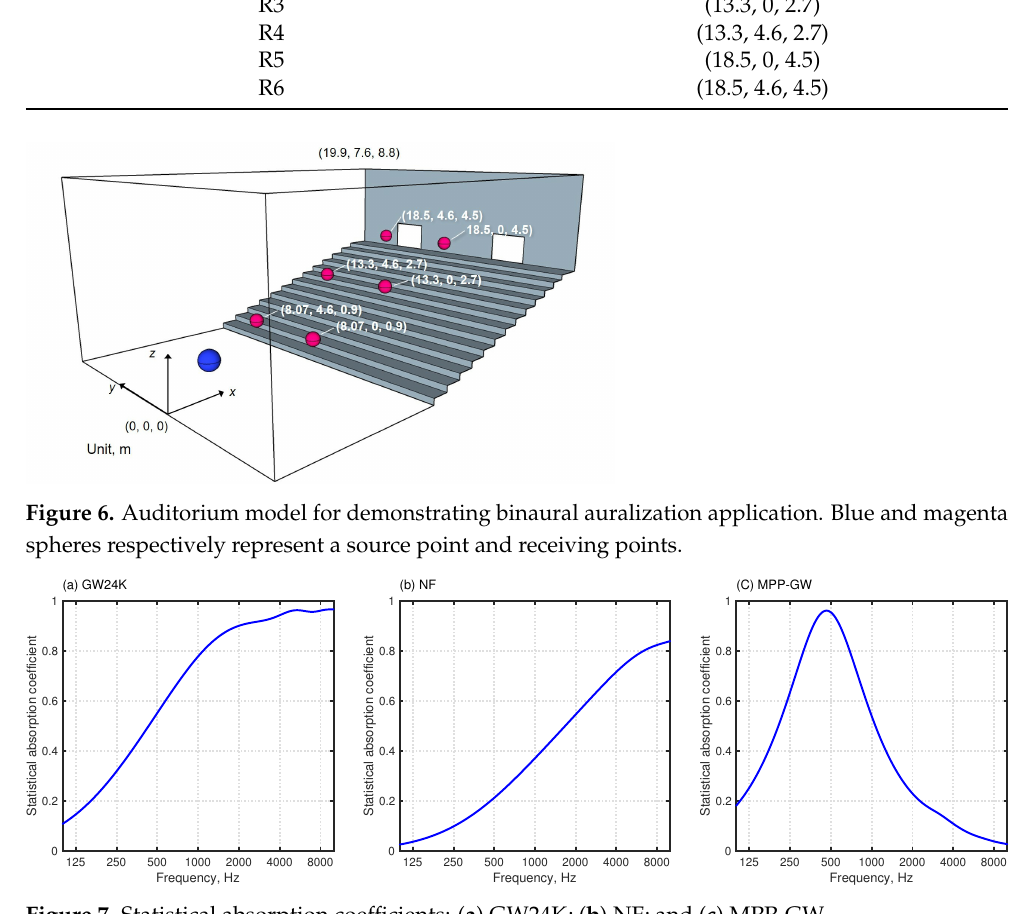
Figure 7. Statistical absorption coefficients: ( a ) GW24K; ( b ) NF; and ( c ) MPP-GW.